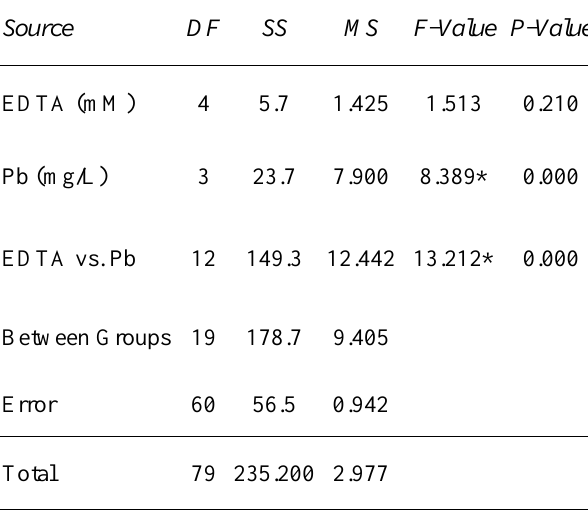
Table 1: Effects of Pb and EDTA concentrations